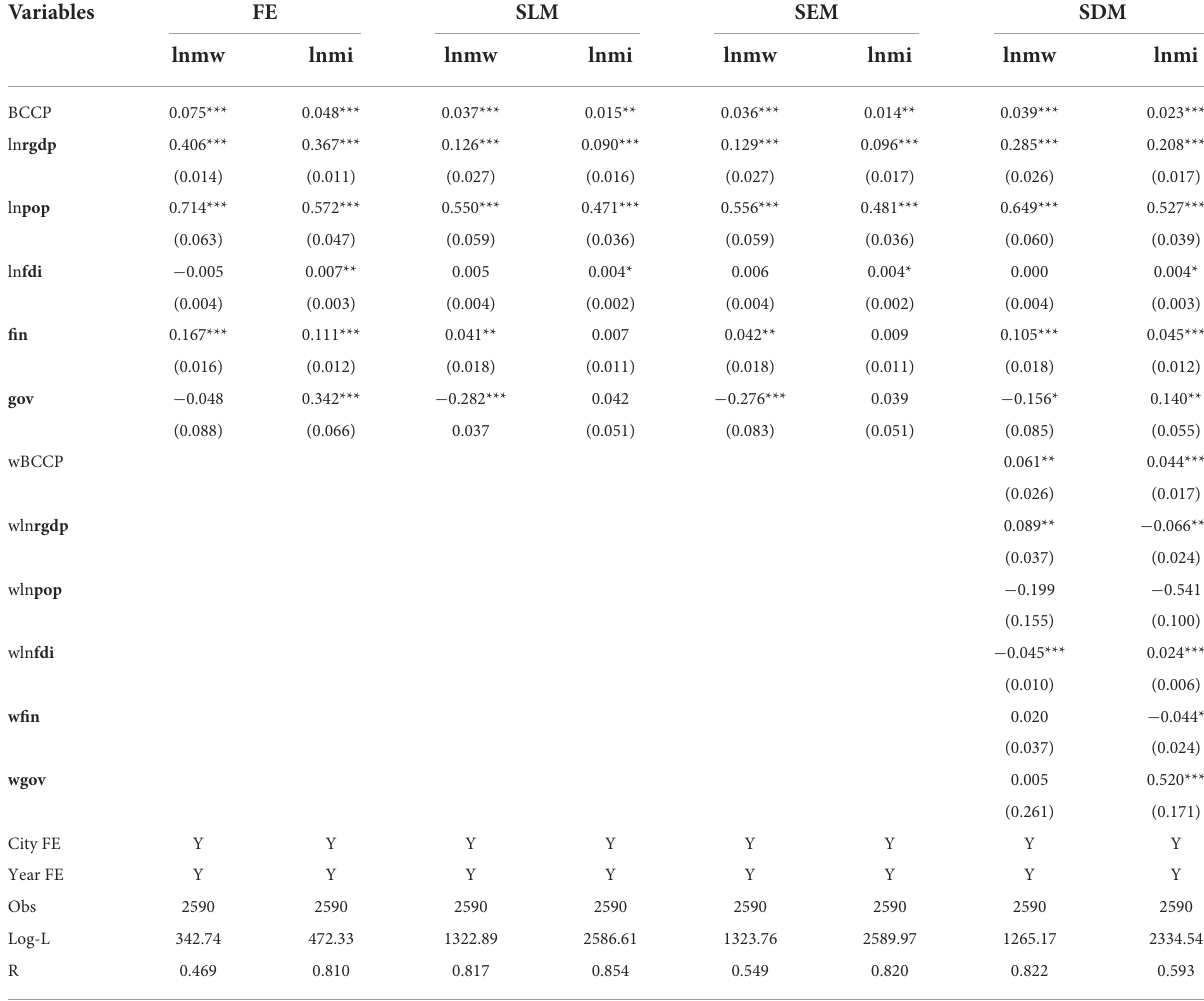
TABLE 4 Impact of information infrastructure development and health care environment.